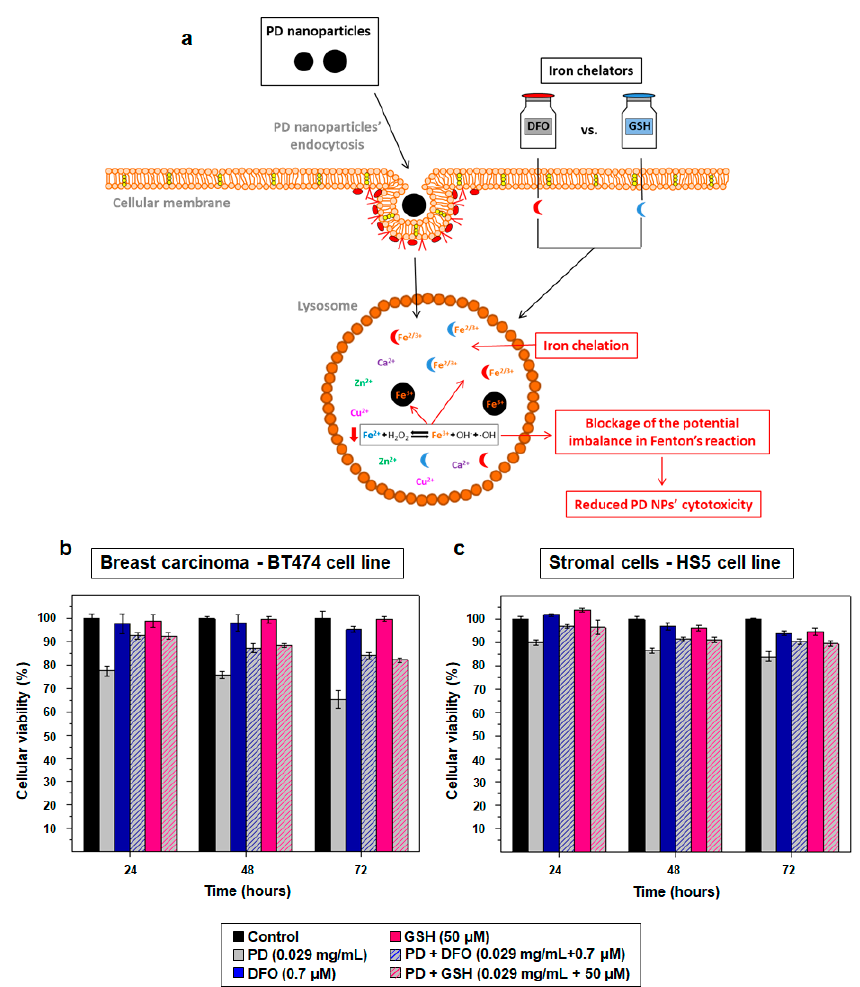
Figure 6. ( a ) Scheme that represents how DFO and GSH could be able to reduce the cellular death caused by the treatment with PD NPs. ( b , c ) Results of the MTT assays carried out with BT474 and HS5 cells after a co-treatment of 115 nm PD NPs (0.029 mg/mL, gray) with DFO (0.7 μ M, blue) and GSH (50 μ M, pink). The results shown are again the mean ± SD of three replicates of each treatment.